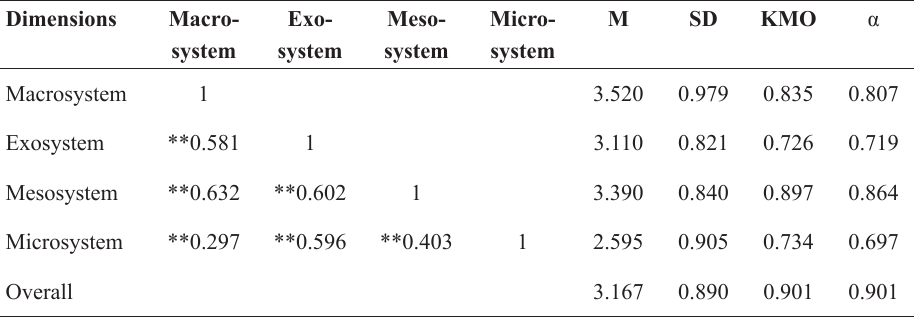
Table 2.Validity, reliability, and coherence of the research survey Dimensions